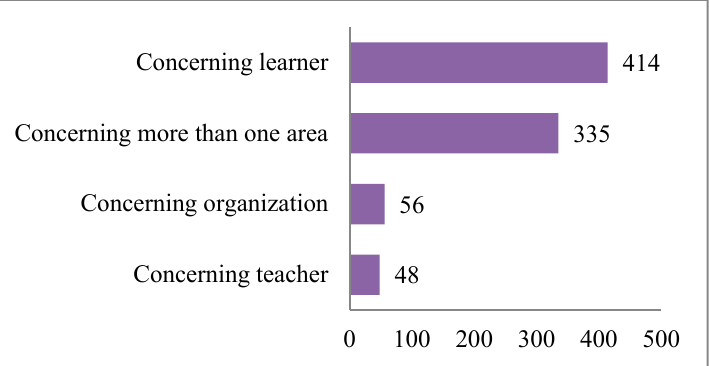
Figure 3. Count of addressed categories from the defined main